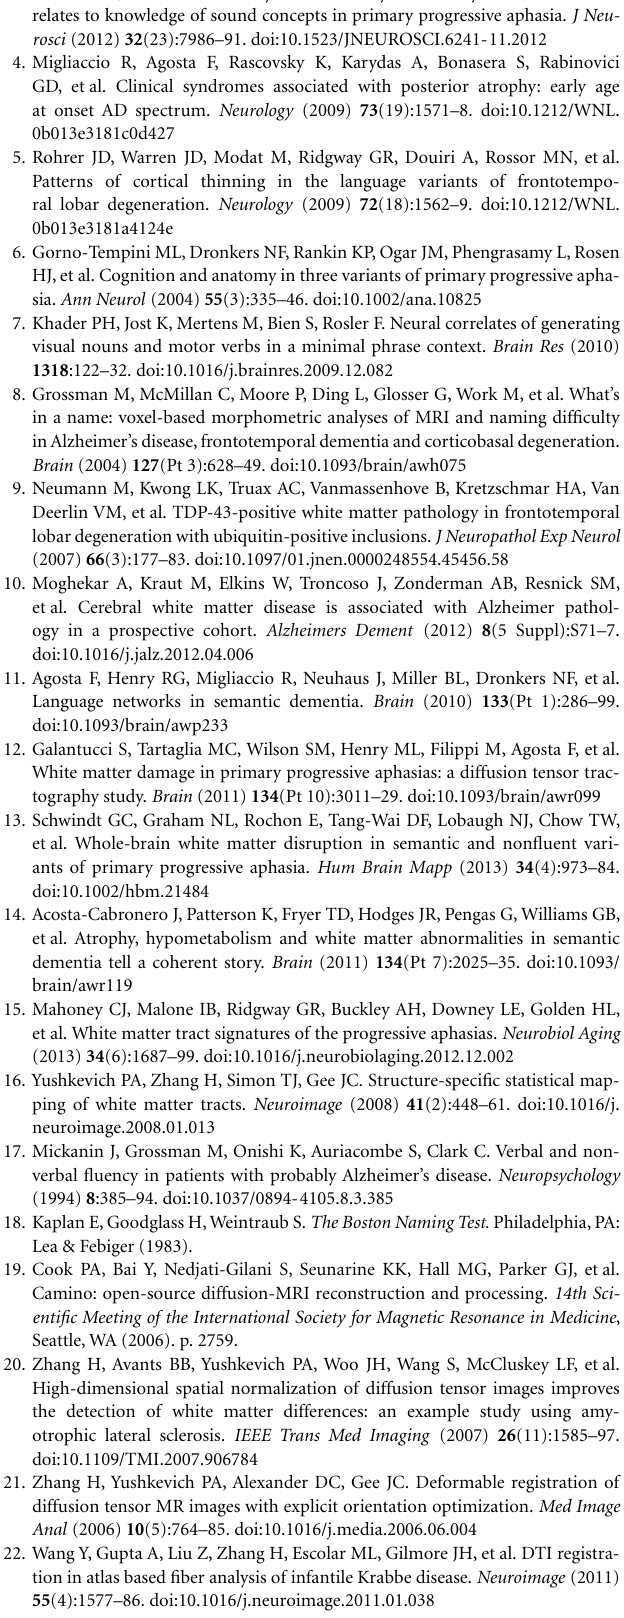
Figure S1 | Gray matter atrophy . Inflated-brain renderings showing significantly decreased GM density in svPPA (A) and lvPPA (B) relative to healthy